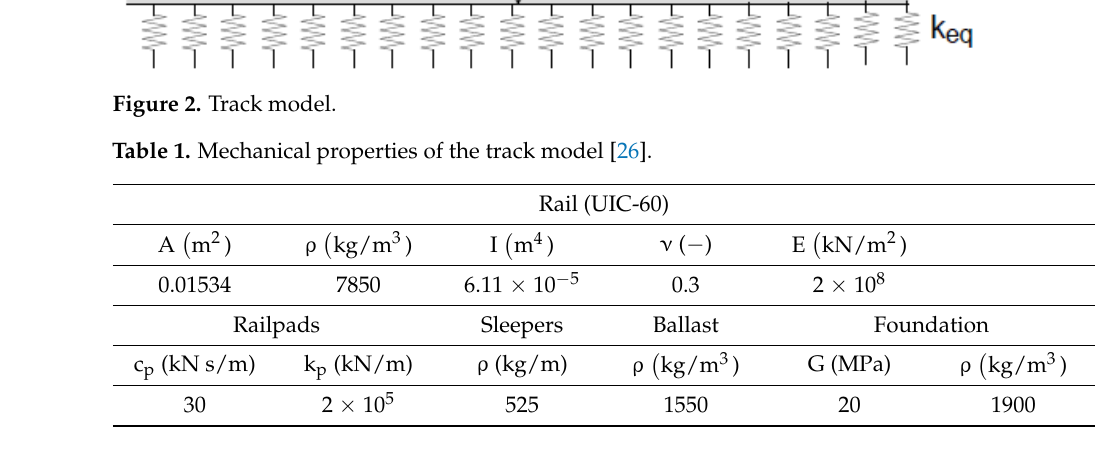
Figure 2. Track model.